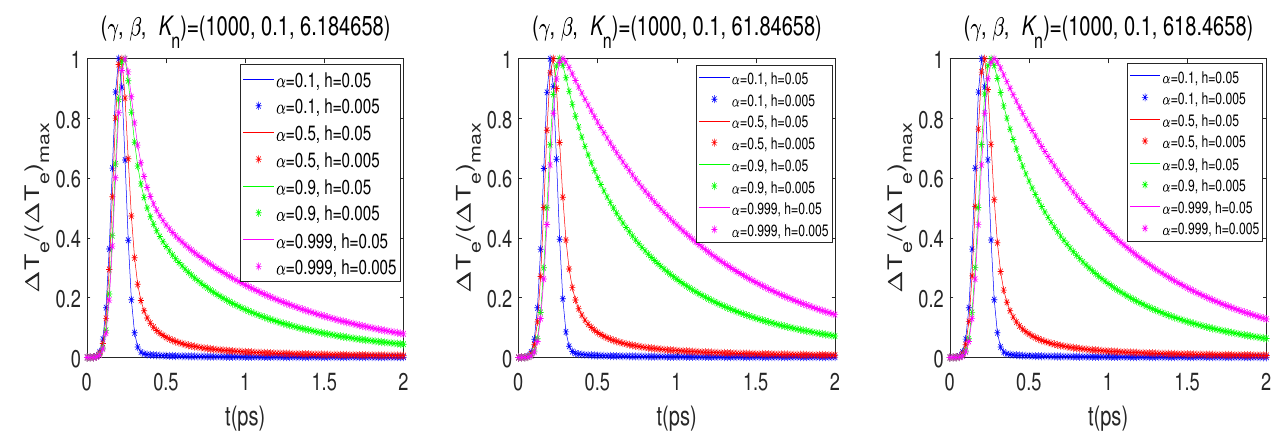
Figure 11. Changes in electron temperature ∆ T e / ( ∆ T e ) max and various K n , α , and ( γ , β ) = ( 1000,0.1 ) .